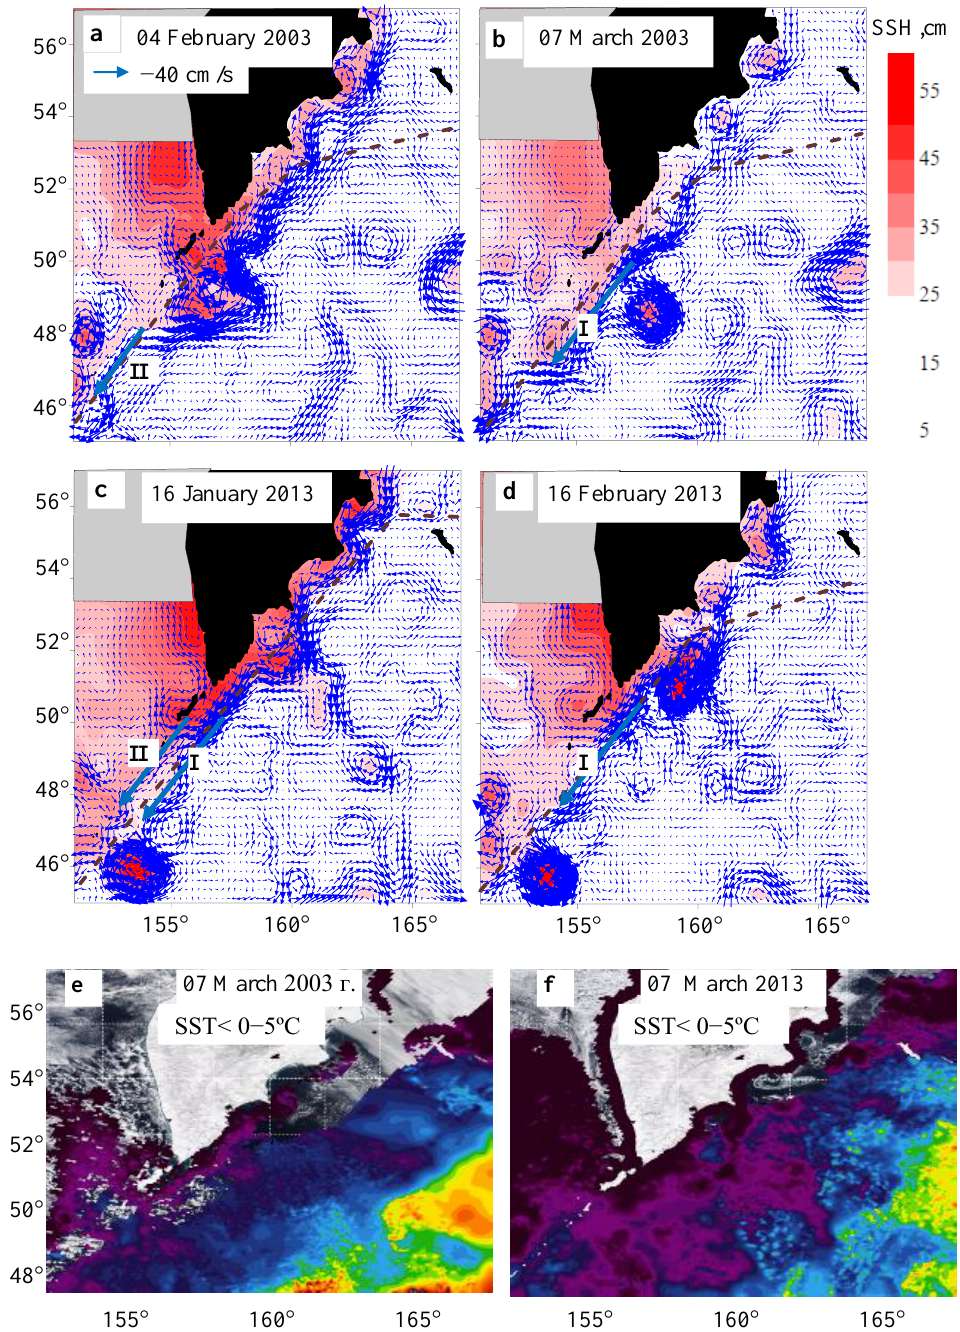
Figure 3. The SSH, geostrophic current velocity ( a – d ), and SST (purple indicates negative tempera- tures) ( e , f ) distributions in the winter of 2003 and winter of 2013. Brown dashed lines ( a – d ) show the location of the sections where seawater parameters were measured; blue arrows indicate the coastal (II) and off-shore (I) branches of the EKC.